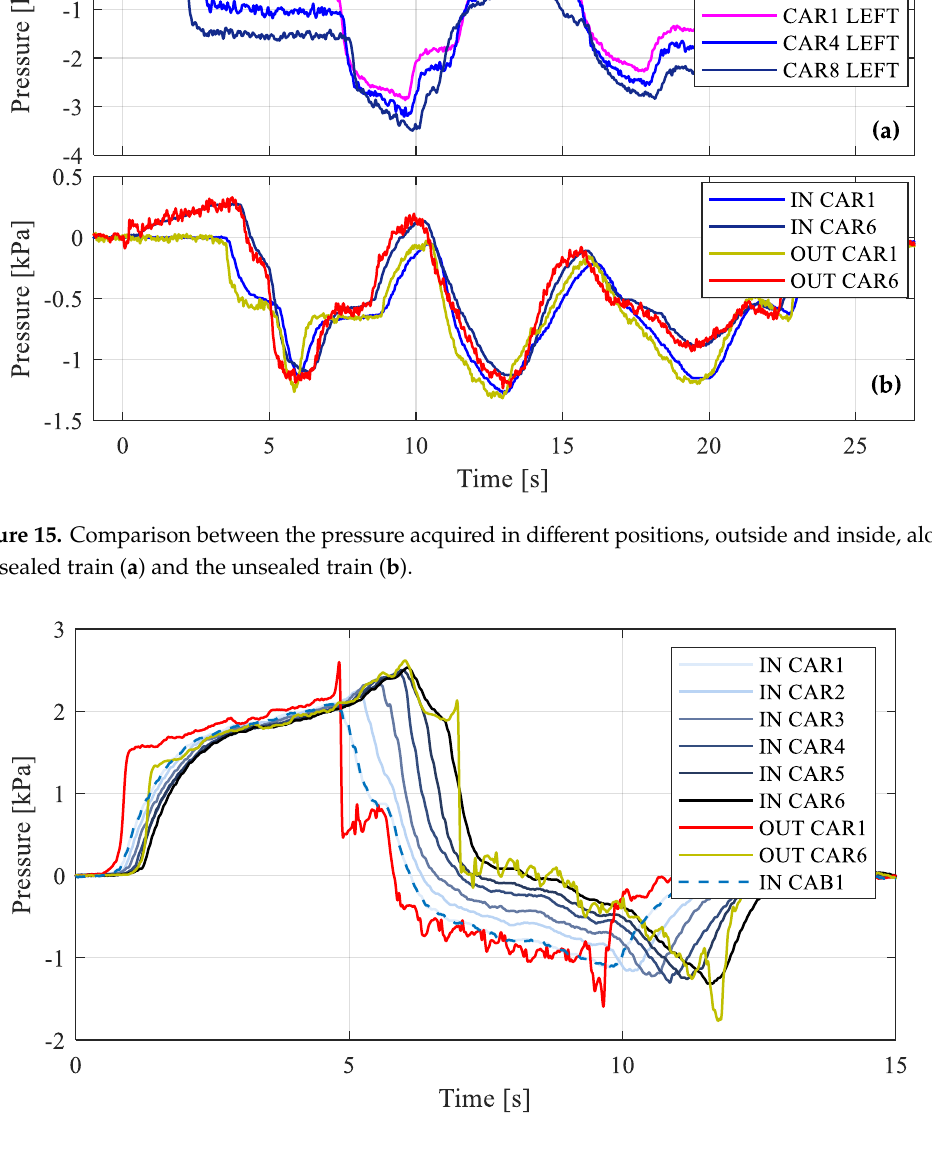
Figure 16. Comparison between the pressure acquired in different positions along the unsealed train outside and inside in case of crossing within a tunnel.